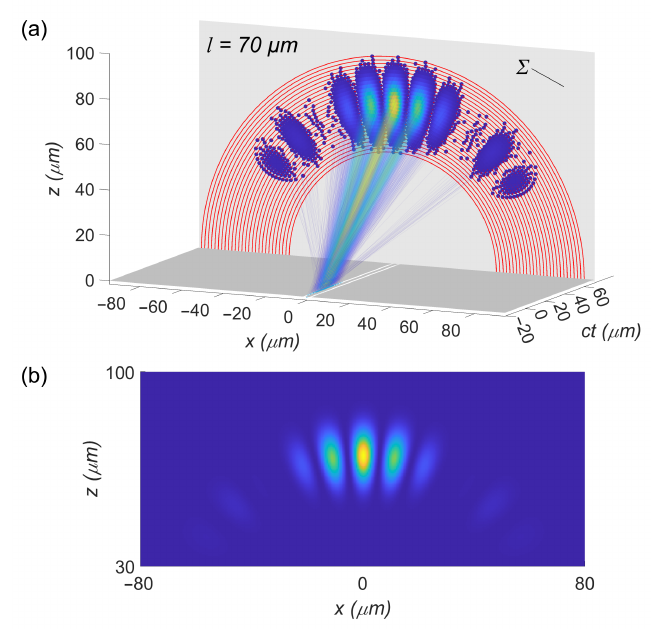
Figure 4. Simulation of the double-slit experiment in the 4+1 formalism when the center of the single-photon wave packet has passed l = 70 µ m beyond the double slit. ( a ) The configuration of particle worldlines and their end events in the hypersurface Σ ( τ ) (dots), with colors representing the local density. Only worldlines passing through the left slit are shown (right slit is simply mirrored). Red half-circles indicate subgroups of worldlines that are emitted at different times by the source. The hypersurface Σ ( τ ) (light gray) is shown that collects the endpoints of all worldlines. ( b ) The quantum measure Q ( x , z ) in Σ ( τ ) , which is proportional to the quantum probability